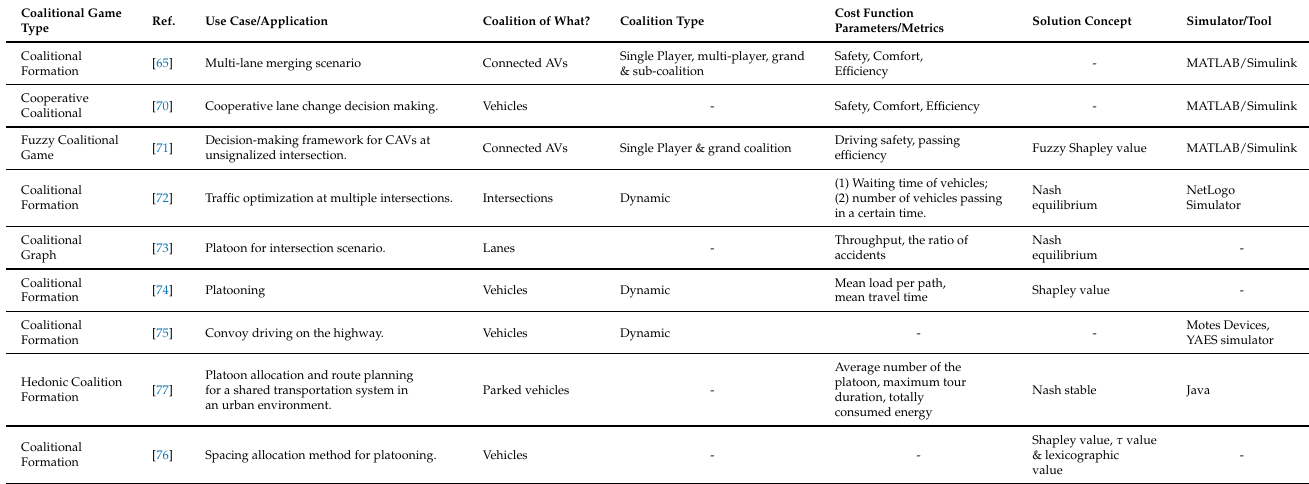
Table 3. Comparison of coalitional game theory